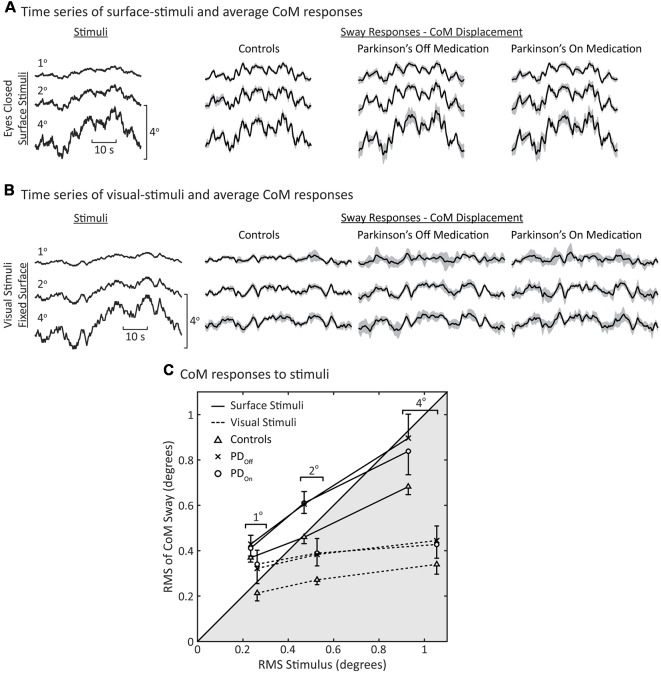
Sway during surface and visual stimuli. Time series of average center of mass (CoM) responses to (A) surface stimuli and (B) visual stimuli. The shaded gray regions represent the 95% confidence intervals of the mean response across subjects. (C) Root mean square (RMS) of the CoM sway vs. RMS of the stimulus. Each data point represents the average behavior across subjects (N = 8 for each group). Data in the unshaded half of the figure represents CoM responses that are larger than the stimulus (ratio >1); the shaded portion of the plot represents responses that are smaller than the stimulus (ratio <1). Note that the surface and visual stimuli were different pseudorandom ternary sequences (PRTSs; see Stimuli columns in (A,B) and see “Materials and Methods” section), consequently the RMS of the stimuli are slightly different for the same peak-to-peak stimulus amplitude. The error bars denote standard errors for the surface-stimulus data. For clarity, only single-sided error bars are shown.